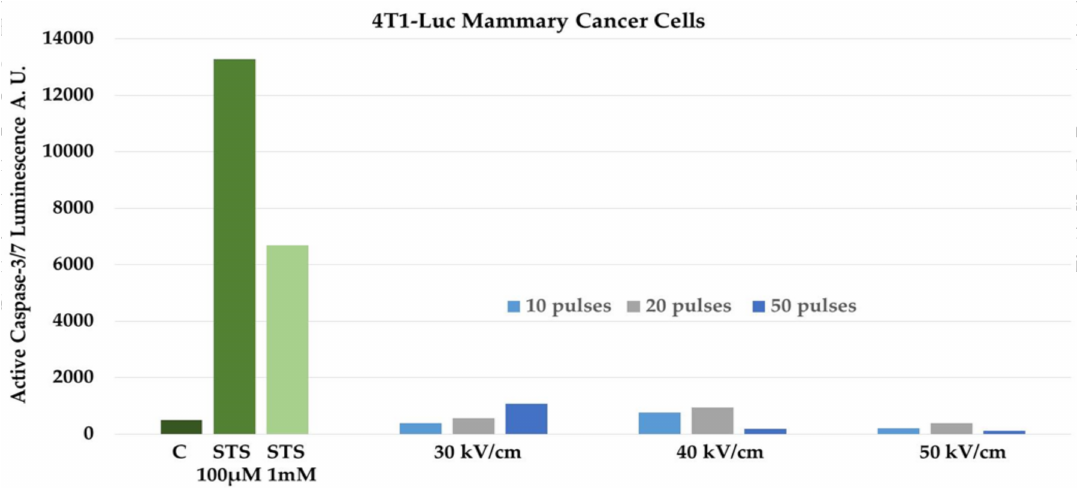
Figure 1. Staurosporine (STS), but not Nanopulse Stimulation (NPS), induces caspase-3/7 activity in 4T1-Luc mammary cancer cells. 4T1-Luc cells were treated with 100 µ M and 1 mM STS or treated with 10, 20, and 50 pulses with 60 ns pulse durations and electric fields of 30, 40, and 50 kV/cm. Control (C) cells were untreated with STS or NPS. Five (5) hours later, caspase-3/7 activity was determined using the Caspase-Glo assay (ProMega, Madison WI) according to the supplier’s recommendation. The figure represents a typical assay with triplicate